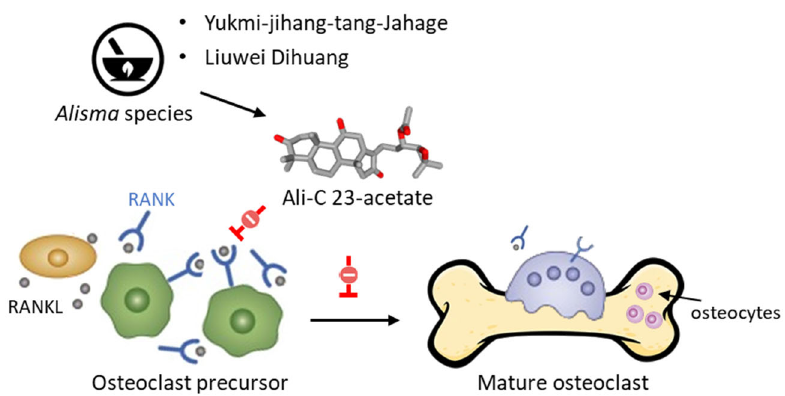
Figure 6. Inhibition of RANKL ‐ induced osteoclast differentiation and function by Ali ‐ C 23 ‐ acetate (AC23A). The compound would act selectively on osteoblast precursors, rather than mature osteoblasts, by inhibiting RANKL ‐ induced osteoclastogenesis. The compound blocks phosphorylation of JNK and reduces expression of osteoclastogenic mediators, such as TRAP, c ‐ Fos, MMP9, NFATc1, and cathepsin K [104]. AC23A can be found in phytomedicines made from Alisma rhizoma, such as Liuwei Dihuang and Yukmi ‐ jihang ‐ tang ‐ Jahage, both used to treat osteoporosis. Ali ‐ A 24 ‐ acetate also functions as an inhibitor of osteoclastogenesis. It inhibits RANKL ‐ mediated osteoclast differentiation by downregulating the expression of nuclear factor of activated T cell 1 (NFATc1), which is an important regulator of osteolysis [105]. In an animal model of postmenopausal osteoporosis (ovariectomized mice), a daily ad ‐